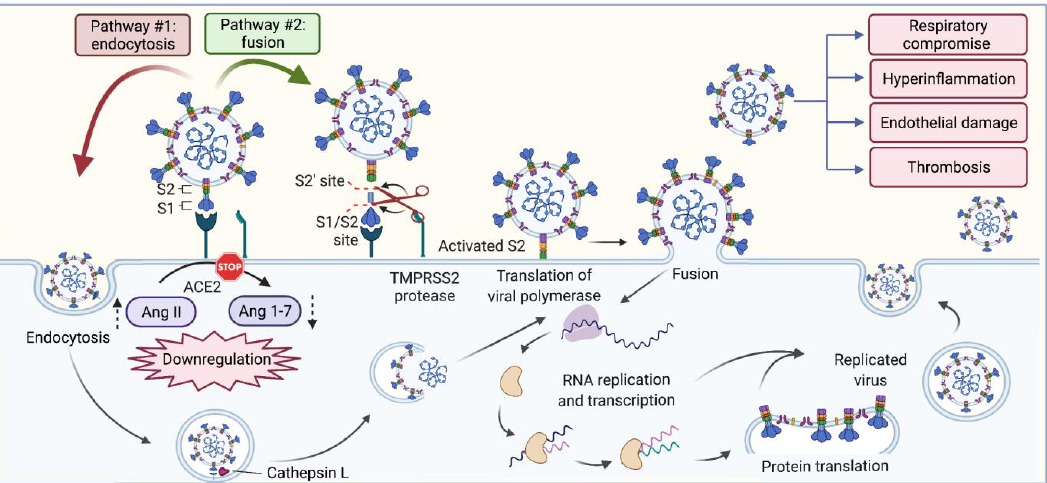
Figure 1 . SARS-CoV-2 entry into the host cell. As an enveloped virus, SARS-CoV-2 can enter the host cell through one of two pathways — pathway #1, endosomal entry and pathway #2, direct cell surface entry. In both entry forms, the S protein binds to the ACE2 receptor and must be primed and activated by proteases at the S1/S2 and S2 ’ site. SARS-CoV-2 infection results in the downregulation of the ACE2 receptor, leading to an increase in Ang II and decrease in its conversion to Ang-(1-7). In pathway #1, SARS-CoV-2 undergoes clathrin-mediated endocytosis, and is primed by host protease Cathepsin L present in the endolysosome, followed by membrane fusion and release of viral genomic material. In pathway #2, the S protein is cleaved by TMPRSS2 at the cell membrane, where it directly fuses and releases viral RNA without entering an endolysosome. Both pathways join in the host cytoplasm, where a viral polymerase is translated, followed by RNA replication, structural protein translation, viral assembly, and release of progeny virus that continue to spread the infection to other cells. SARS-CoV-2 infection leads to respiratory compromise by causing lung injury, results in excessive inflammation with overactivation of leukocytes and production of inflammatory mediators, results in direct and inflammation-mediated damage to the endothelium, and induces a pro-thrombotic state. Reproduced with permission from Elsevier: Nitric Oxide, 128 (2022), 72 – 102 [71]. Abbreviations: ACE2, angiotensin-converting enzyme 2; Ang, angiotensin; S protein, spike protein; SARS-CoV-2, severe acute respiratory syndrome coronavirus 2; TMPRSS2, transmembrane serine protease 2.